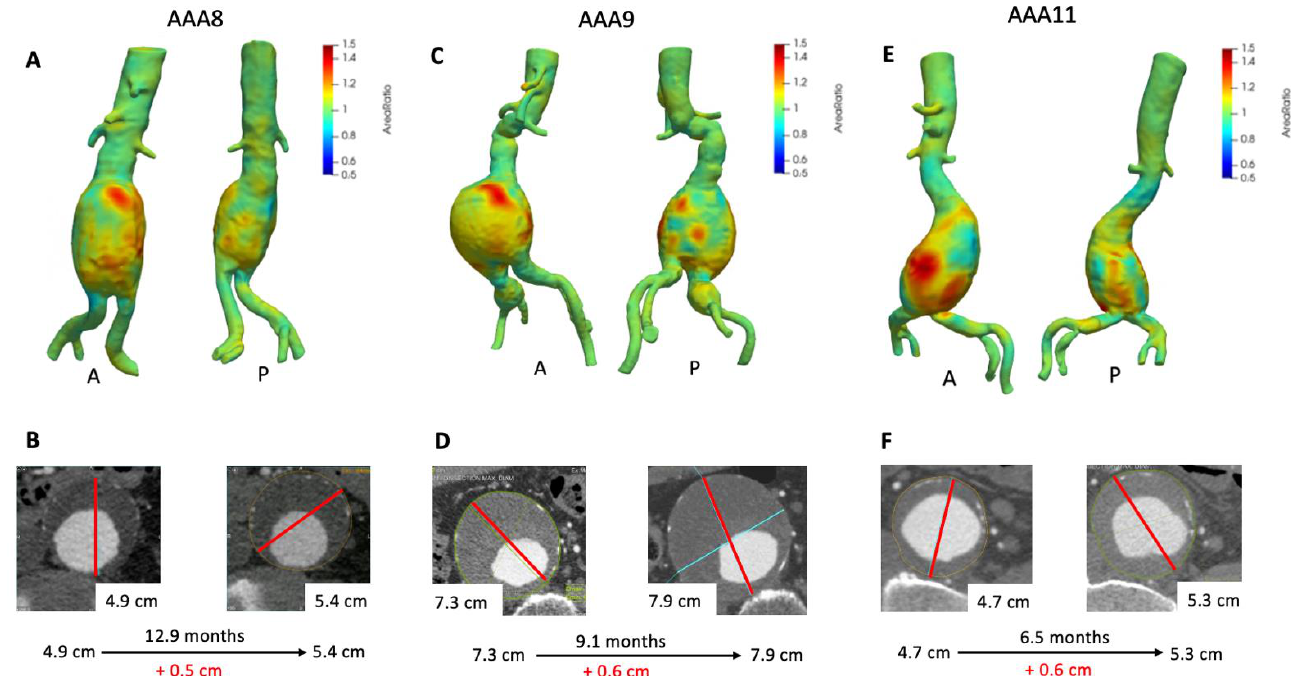
Figure 4. VDM analysis of AAA8, AAA9, and AAA11. VDM of AAA8 shows a significant amount of growth anteriorly and mild growth posteriorly ( A ), with interval increase of maximum diameter of 0.5 cm over 12.9 months ( B ). VDM of AAA9 shows an area of significant anterior growth and a few areas of growth posteriorly and laterally, and there was mild growth of a right common iliac artery aneurysm circumferentially ( C ) AAA9 demonstrated 0.6 cm of growth by diameter measurements over 9.1 months ( D ). VDM of AAA11 shows two areas of significant growth anteriorly and mild growth posteriorly ( E ), with interval increase of maximum diameter of 0.6 cm over 6.5 months ( F ). A = anterior projection, P = posterior projection.